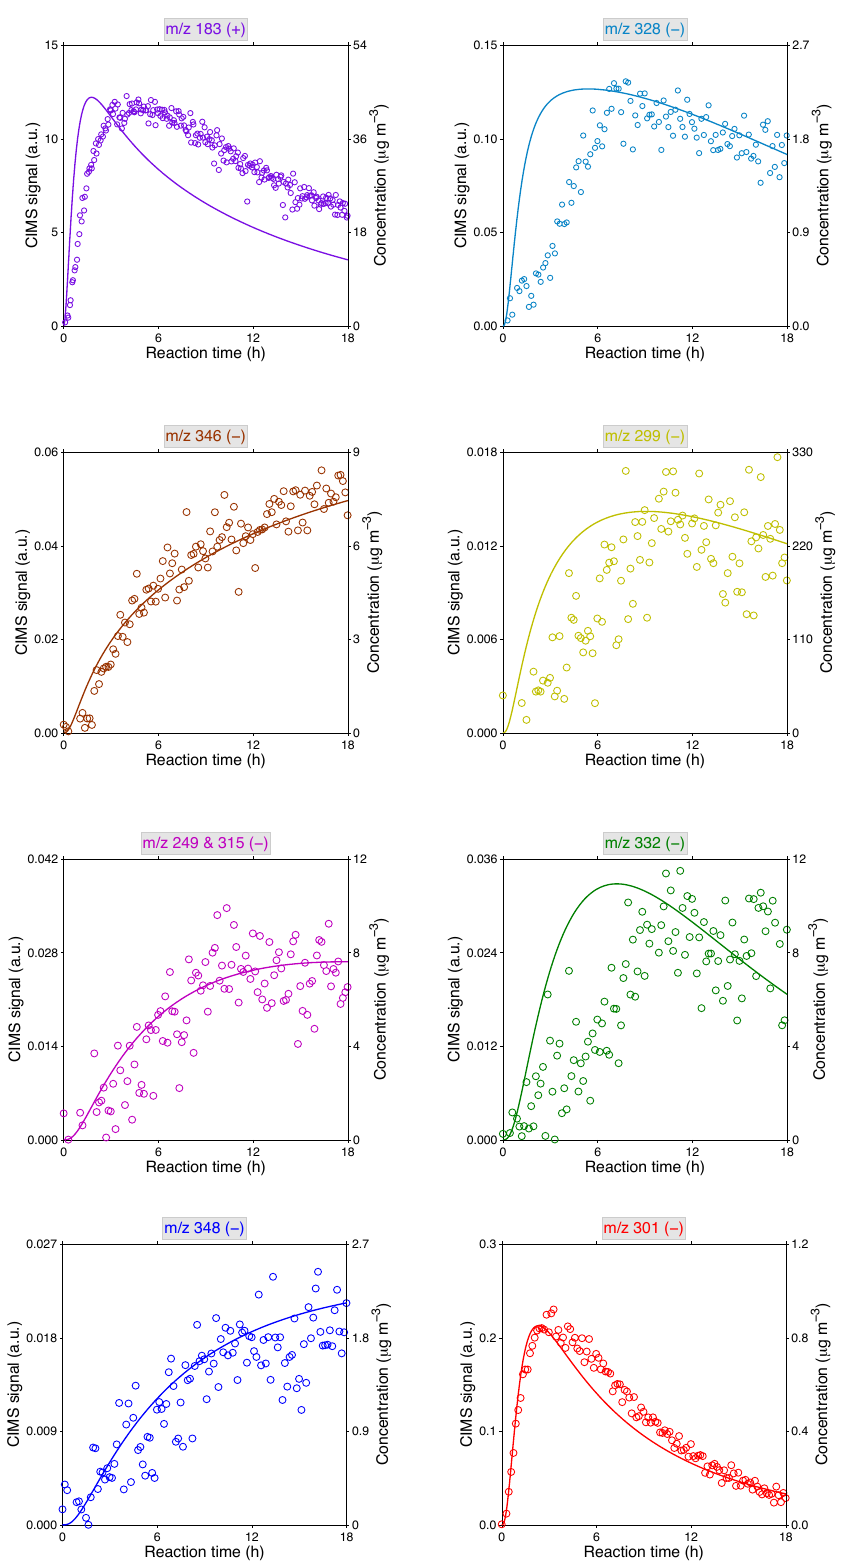
Fig. 10. Comparison of CIMS measured ions in positive and negative mode, with chemical structures proposed in Table 2, with model simulations using experimental conditions of Exp.